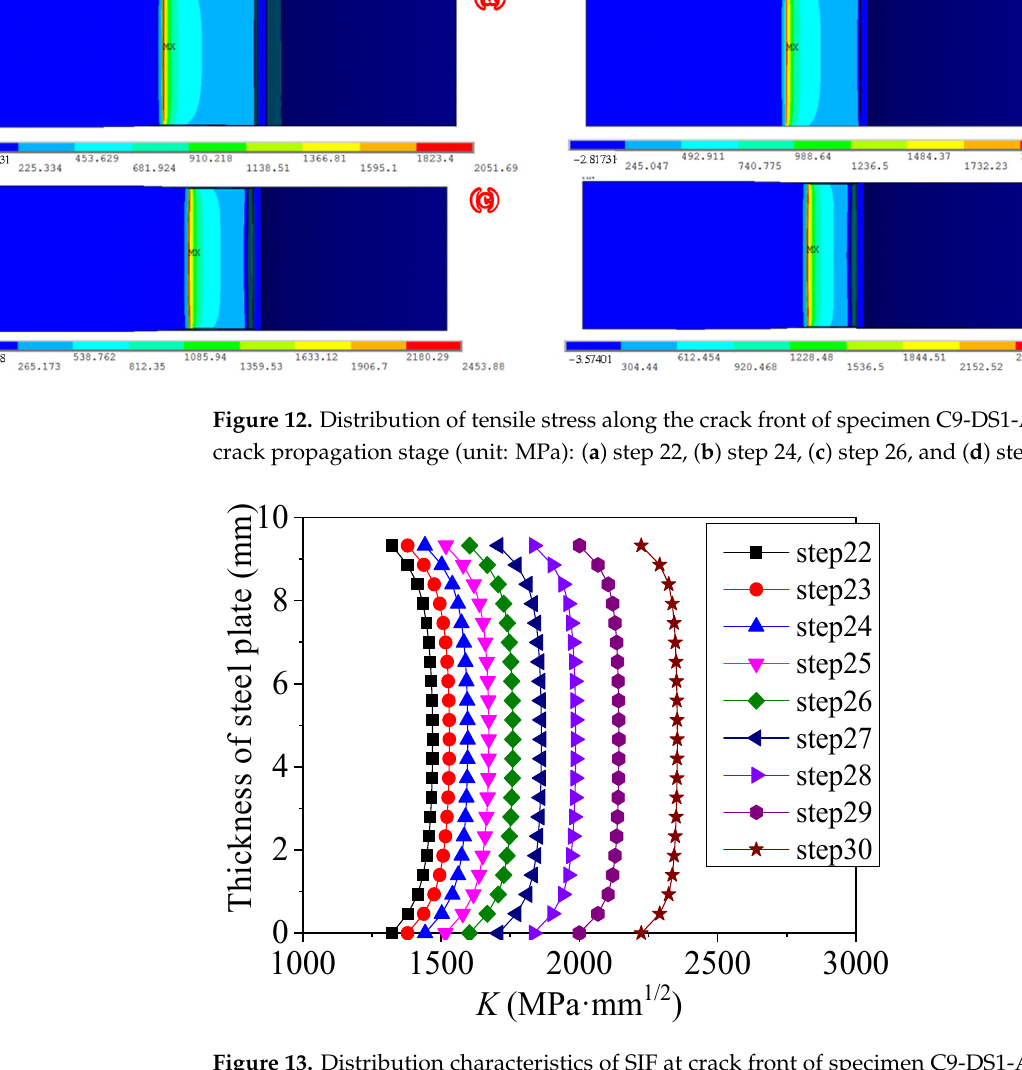
Figure 13. Distribution characteristics of SIF at crack front of specimen C9-DS1-A during through crack propagation stage.